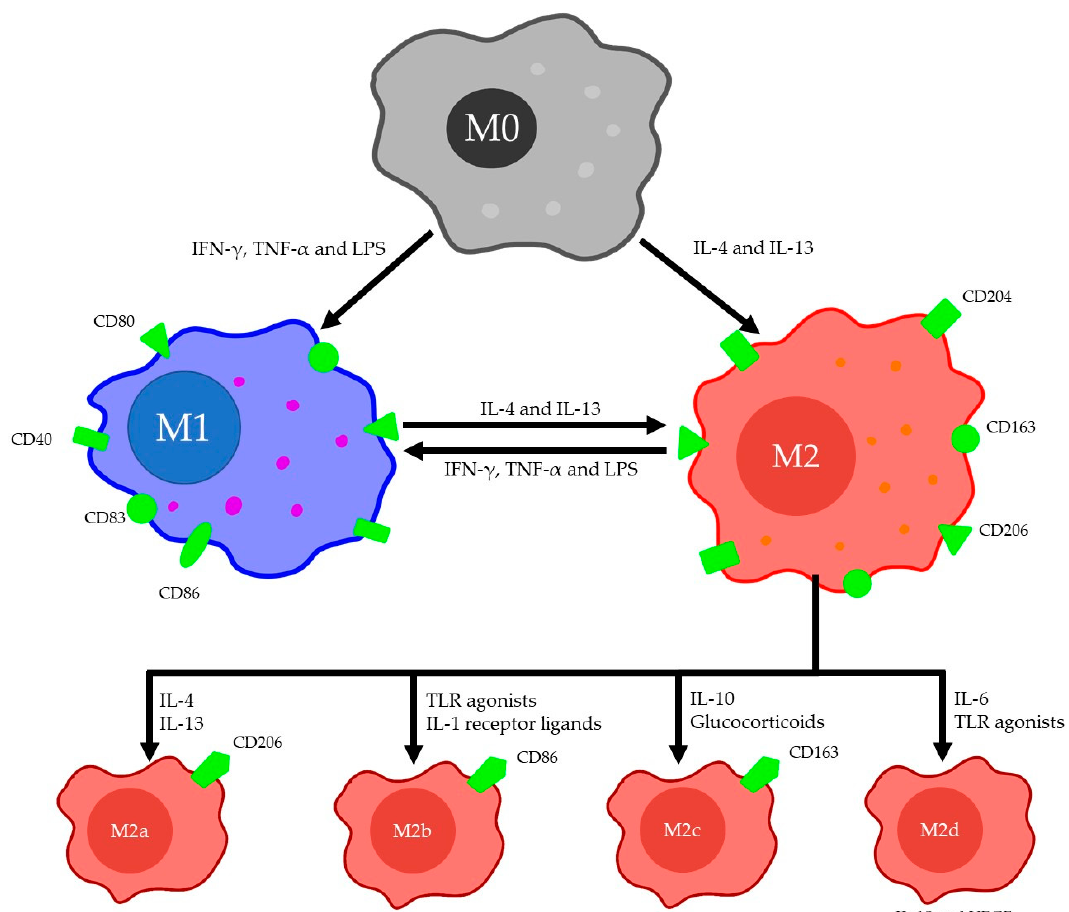
Figure 1. Macrophage Classification. The arrows show the direction and polarization plasticity with inducing factors. Expression of surface markers and production of cytokines/factors by macrophage populations are shown.